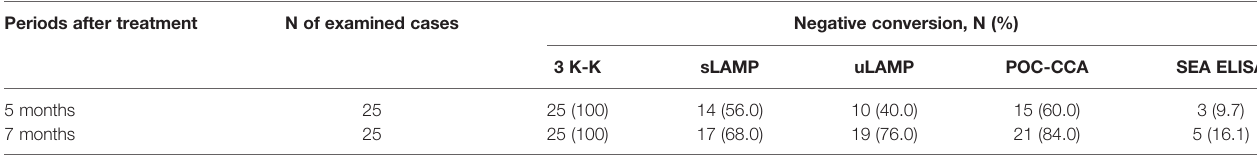
TABLE 3 | Negative conversion of the different diagnostic examinations in 25 patients 5 and 7 months after completion of praziquantel treatment. Periods after treatment N of examined cases